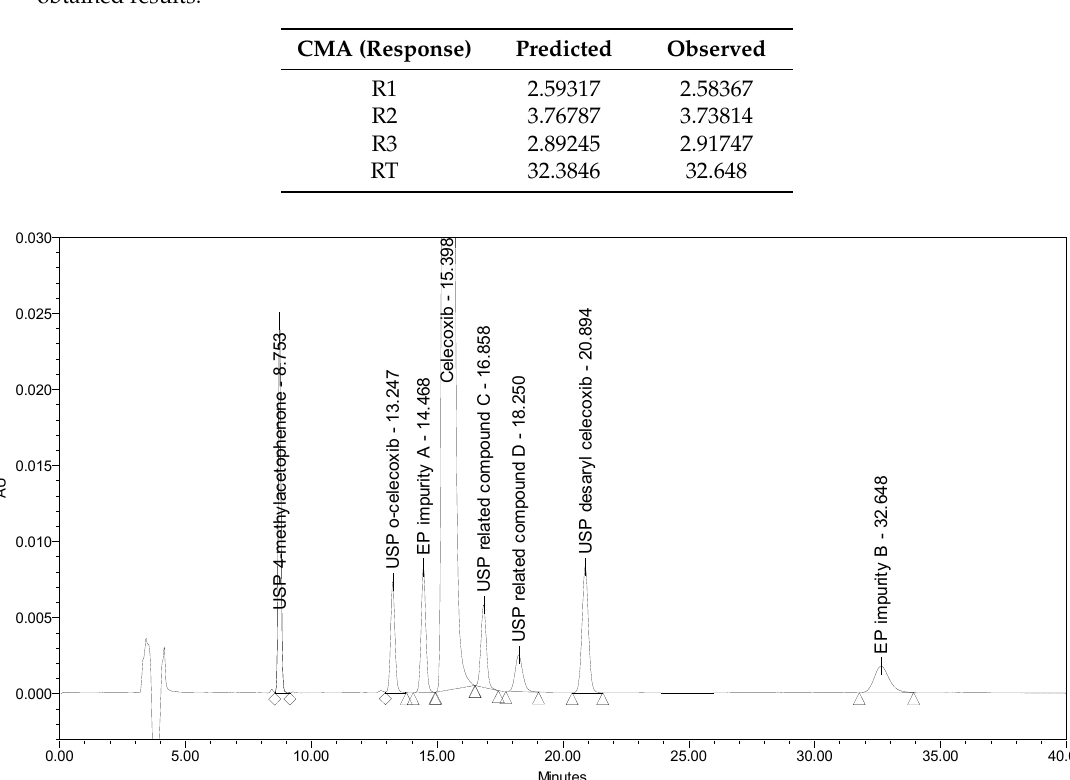
Figure 9. A chromatogram of celecoxib at a concentration of 0.5 mg/mL spiked with seven process- Figure9. Achromatogramofcelecoxibataconcentrationof0.5mg / mLspikedwithsevenprocess-related related impurities at the 0.5% level obtained using optimized chromatographic conditions. impurities at the 0.5% level obtained using optimized chromatographic